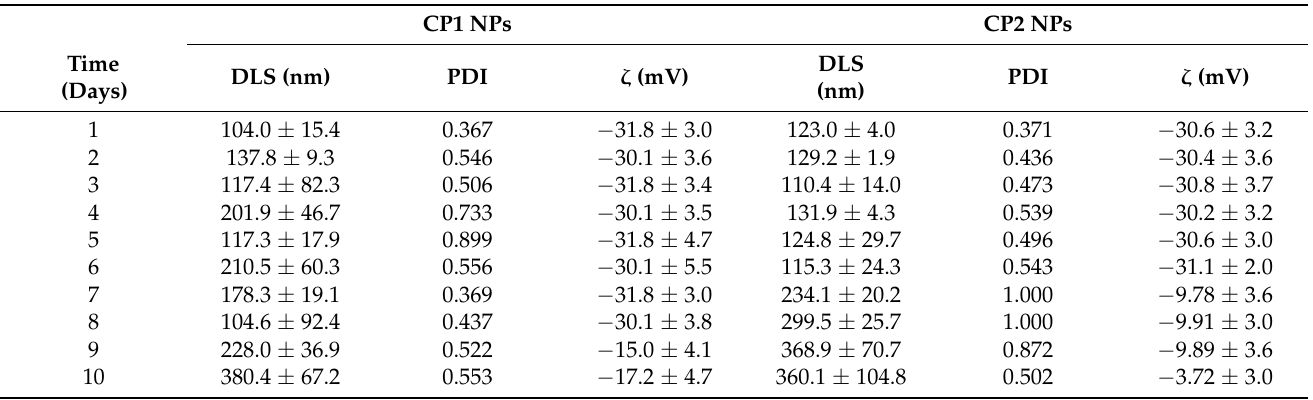
Table 2. Influence of storage on diameter, PDI, and zeta potential of CP1 and CP2 NPs with the extension of time in water. a.